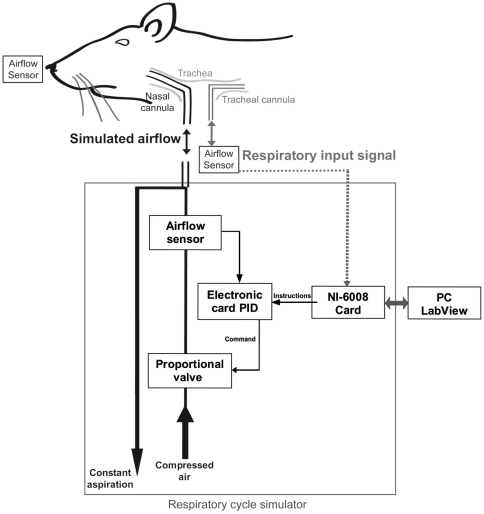
Respiratory cycle simulator.This apparatus consists of an electronic part (PID card, airflow sensor and proportional valve), an acquisition card (NI-6008 analog input/output) and a PC (software under LabView®). Using a constant aspiration and a compressed air input passing through the system allowed the simulation of both inhalation and exhalation phases of the respiratory cycle. The simulated airflow was directly sent to the nasal cavity via a nasal cannula. The tracheal cannula allowed the animal to freely breathe and was used to acquire the animal's respiratory signal.